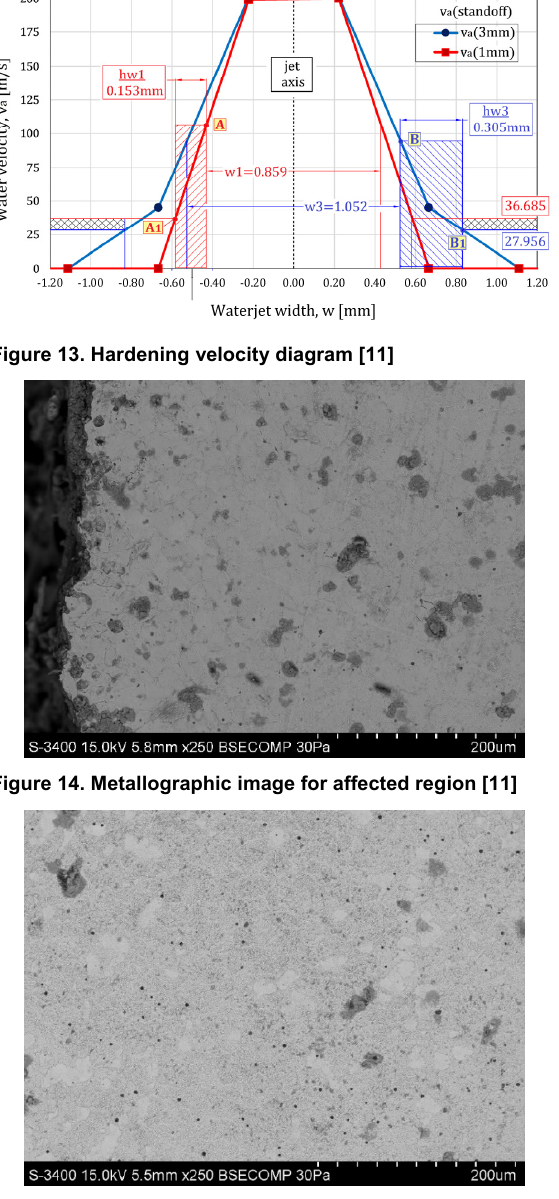
Figure 15. Metallographic image for unaffected region